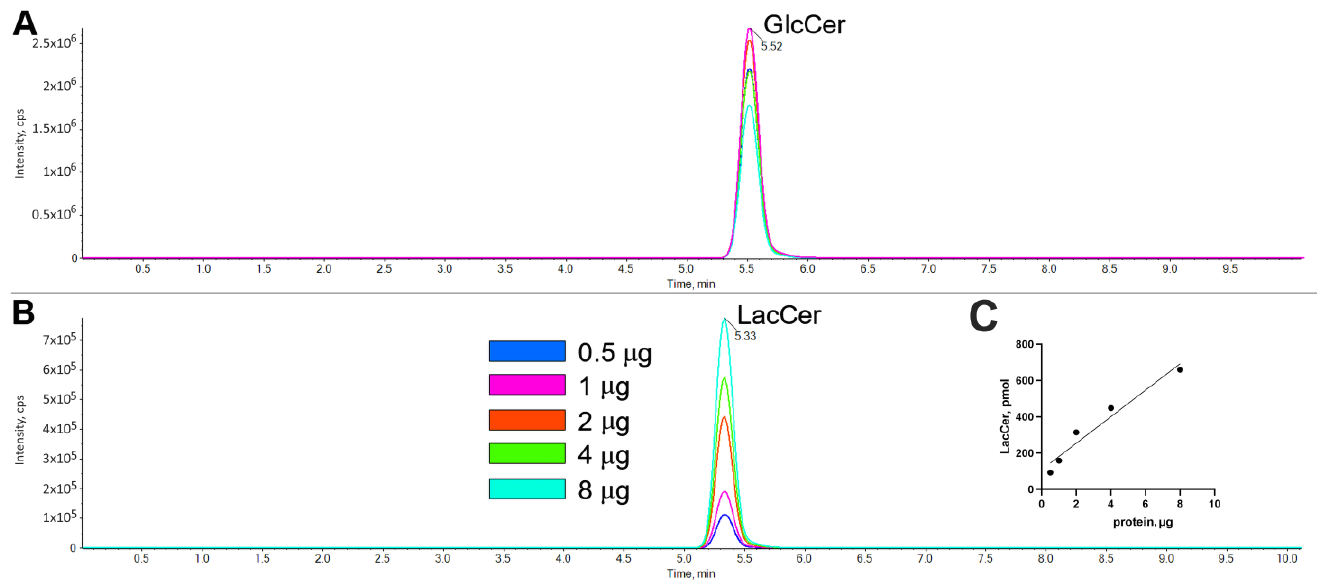
Figure 6. Effect of protein amounts on the enzymatic conversion of GlcCerd7 to LacCerd7 monitored by LC-MS/MS. Comparison of GlcCerd7 ( A ) and LacCerd7 ( B ) profiles using HEK-B4GALT5 as the enzyme source. To obtain these chromatograms, 40 µM of GlcCerd7 with cell homogenates ranging from 0.5 to 8 µg (expressed as proteins) was incubated for 60 min in a reaction volume of 20 μ L. The amounts of LacCer formed at each protein concentration is plotted in subpanel ( C ).